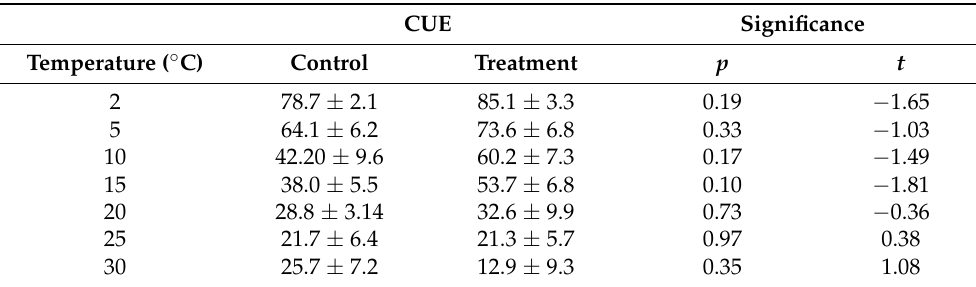
Table 1. Carbon use efficiency (CUE) and t -test results of B. argenteum var. muticum in response to the pulse warming treatment. CUE is the average CUE in % ± SE across control and treatment samples respectively for each temperature step in ◦ C measured. >50% CUE favours photosynthesis, whereas <50% CUE favours